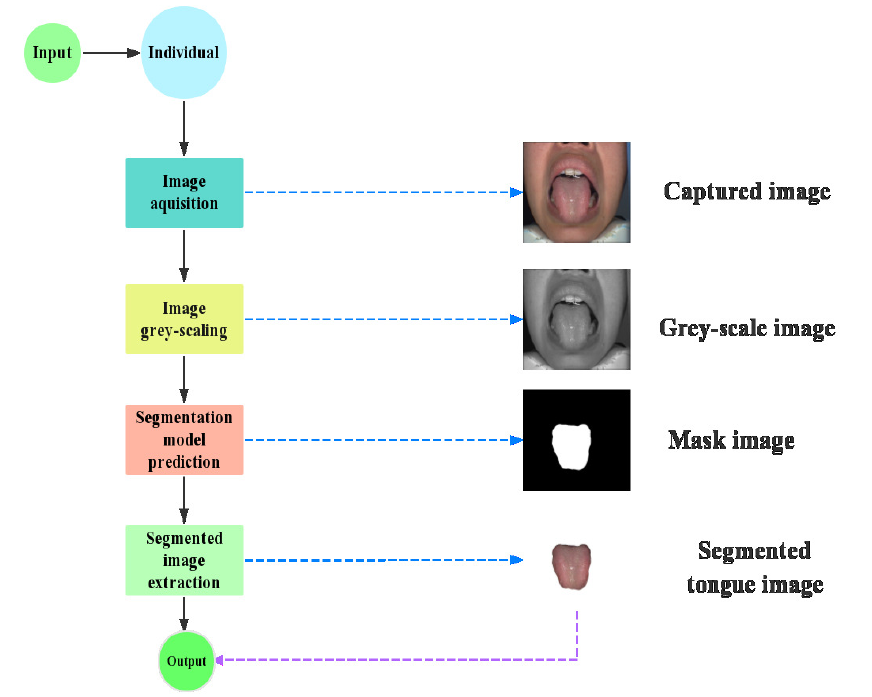
Figure 2. The pipeline of TongueNet. An individual‘s tongue image is first taken as the input. Figures on the right of each dotted line are the output of each procedure. In the image grey-scaling stage, the captured image is converted to grey-scale. Next is the segmentation model prediction stage, where the mask image is predicted. Afterwards, in the segmented image extraction stage, a tongue is segmented from its raw image. The final output is a segmented tongue